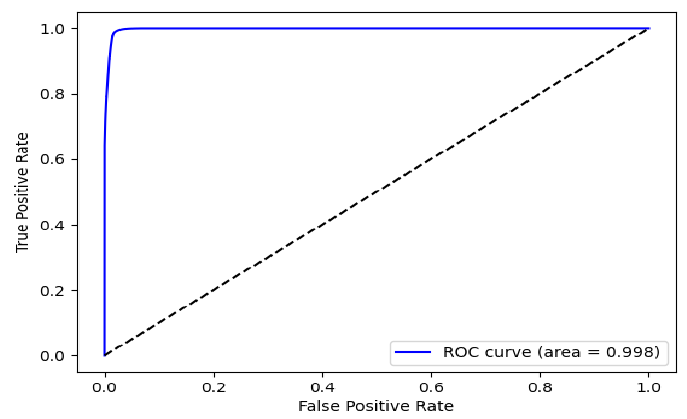
Figure 5. ROC curve for the pixelwise accuracy of